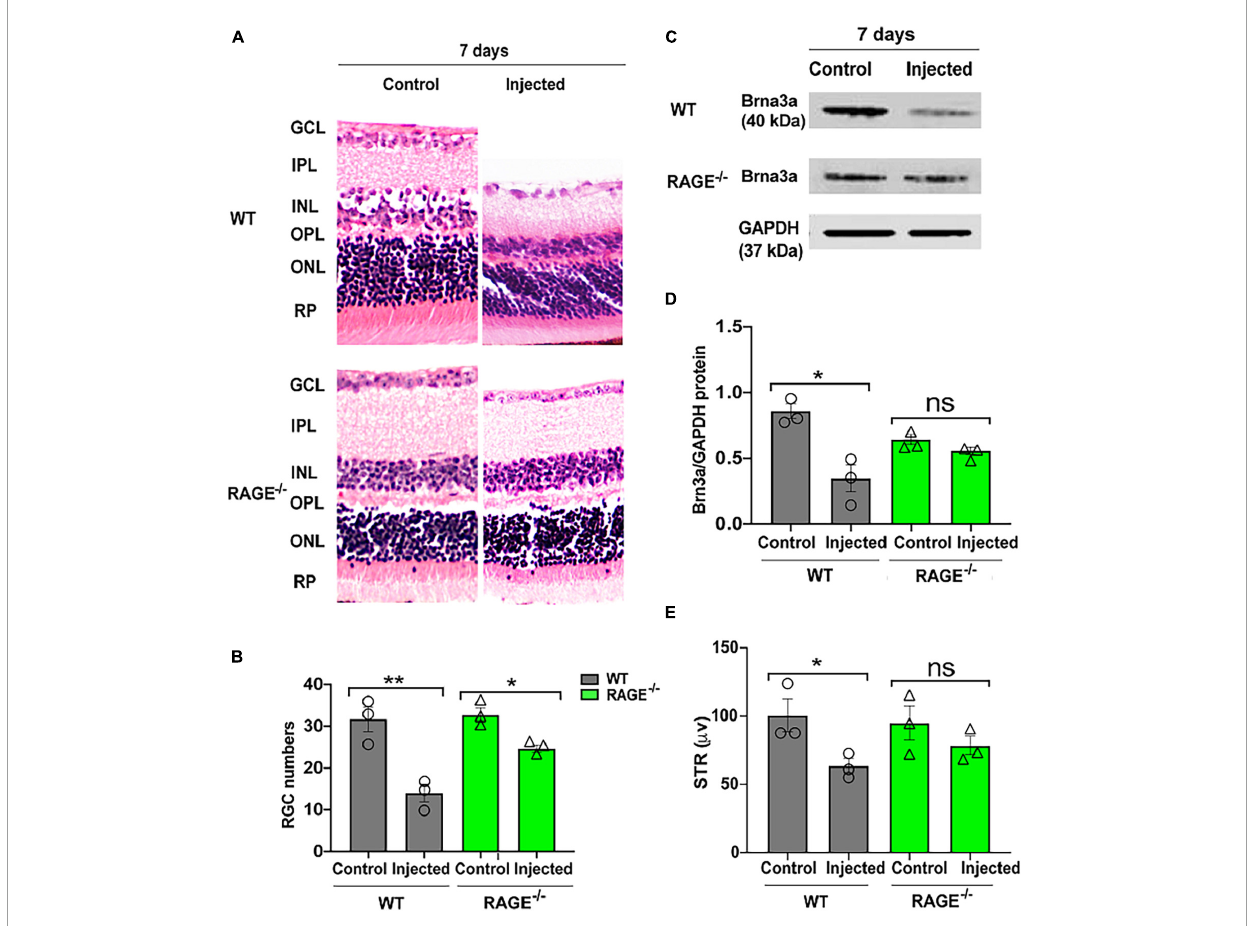
FIGURE3 Intravitreal injection of Aß exacerbates RGC loss and inner retinal dysfunction in WT and not RAGE − / − mice. (A) H&E staining of WT and RAGE − / − retina, 7 days after Aß injection ( n = 3). Significant RGC loss in both WT and RAGE − / − retina. RGCs were measured manually around the optic nerve head in increments of 300 µ m. (B) Comparison of the alterations of RGC numbers in WT and RAGE − / − mice after Aß injection. Using H&E staining, a significant decline in RGC numbers was observed in both WT and RAGE − / − mice ( n = 3). (C) Western blotting of WT and RAGE − / − retinas after intravitreal injection of Aß. GAPDH was used as a control ( n = 3). (D) A significant Brn3a downregulation was observed in WT, 7 days after Aß injection. Brn3a downregulation in Aß injected eyes of each mouse was normalized as Brn3a/GAPDH ( n = 3). (E) Graph representing pSTR analysis of WT and RAGE − / − ( n = 3). * p = 0.02, ** p = 0.008, * p = 0.04, * p = 0.01, ns: no significance, unpaired t -test. The scale bar is 100 µ